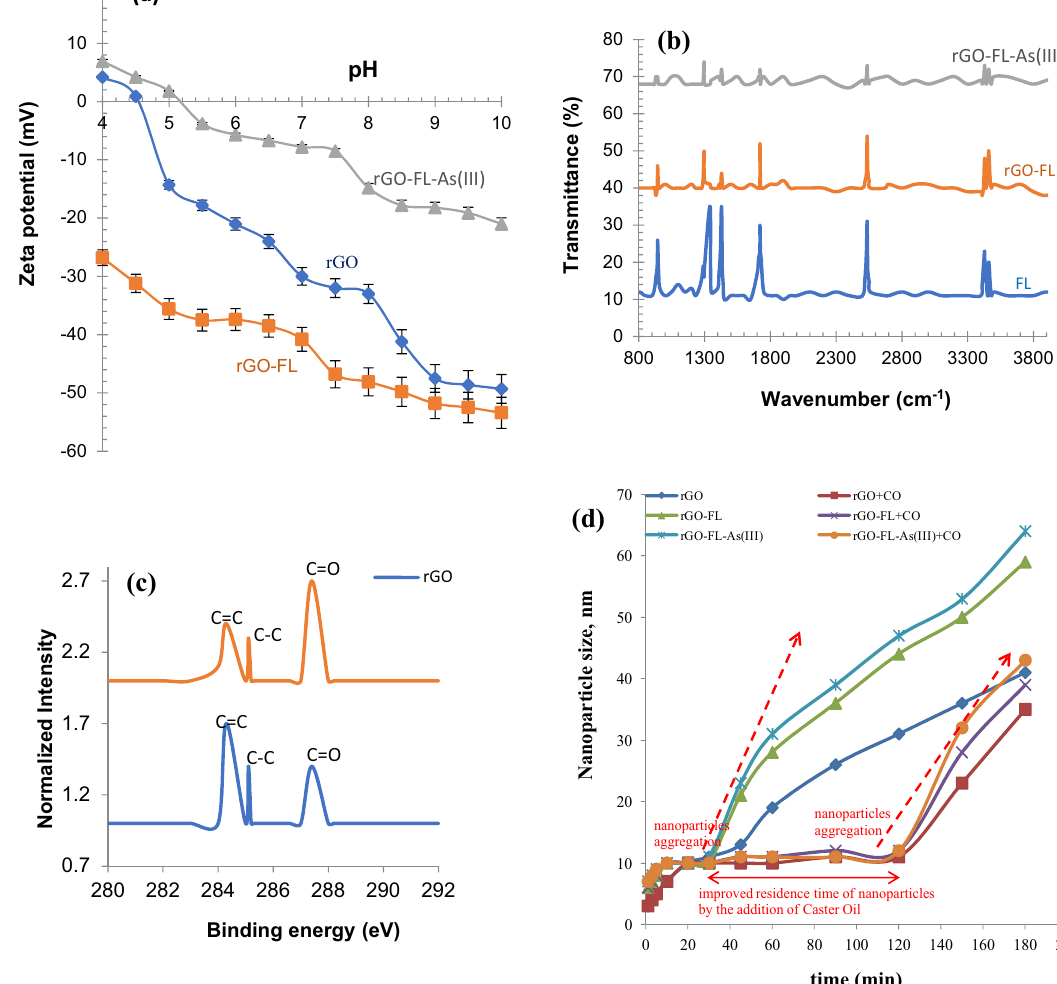
Figure 3. ( a ) Zeta-potential of rGO, rGO–FL and rGO–FL-As(III) nanoparticles ( b ) Infrared spectra of FL, rGO–FL and rGO–FL complex with As(III) ( c ) XPS spectra of rGO and rGO–FL ( d ) Dynamic light scattering results illustrating the growth of the rGO–FL nanoparticles as a function of